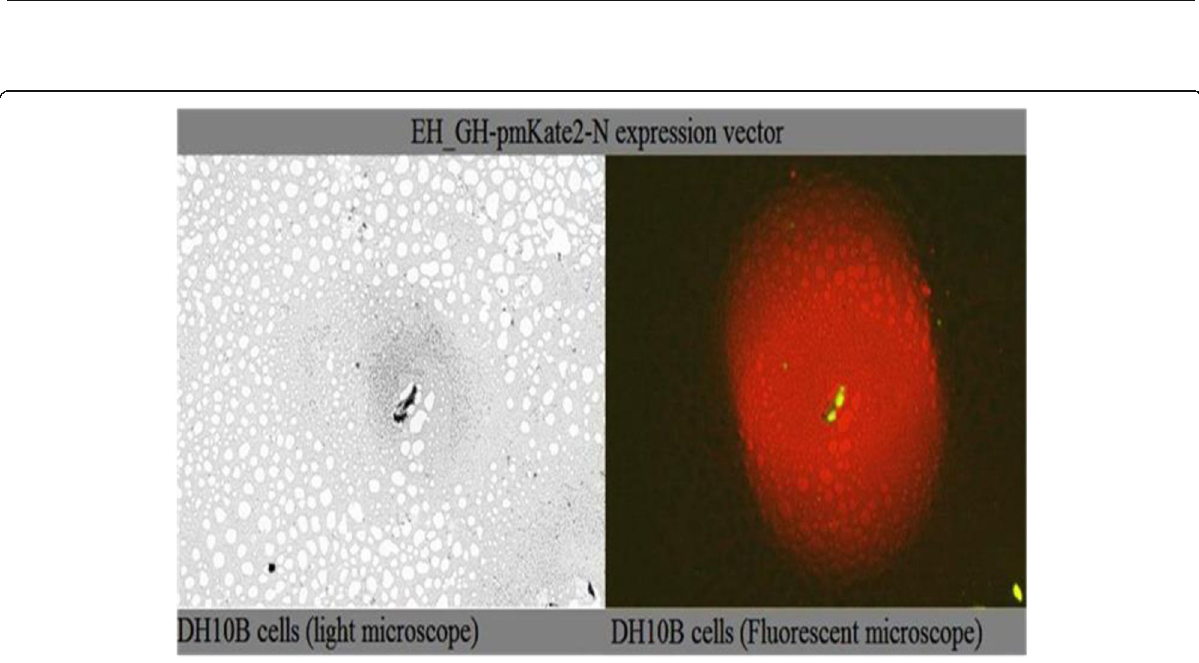
Fig. 5 Expression of the EH_GH – pmKate2 – N vector in transformed DH10B cells under a fluorescence microscope. Left side: the image of the transformed DH10B cell under a light microscope. Right side: the image of the same field of the transformed DH10B cell under a red fluorescent filter (excitation 588 nm and emission 633